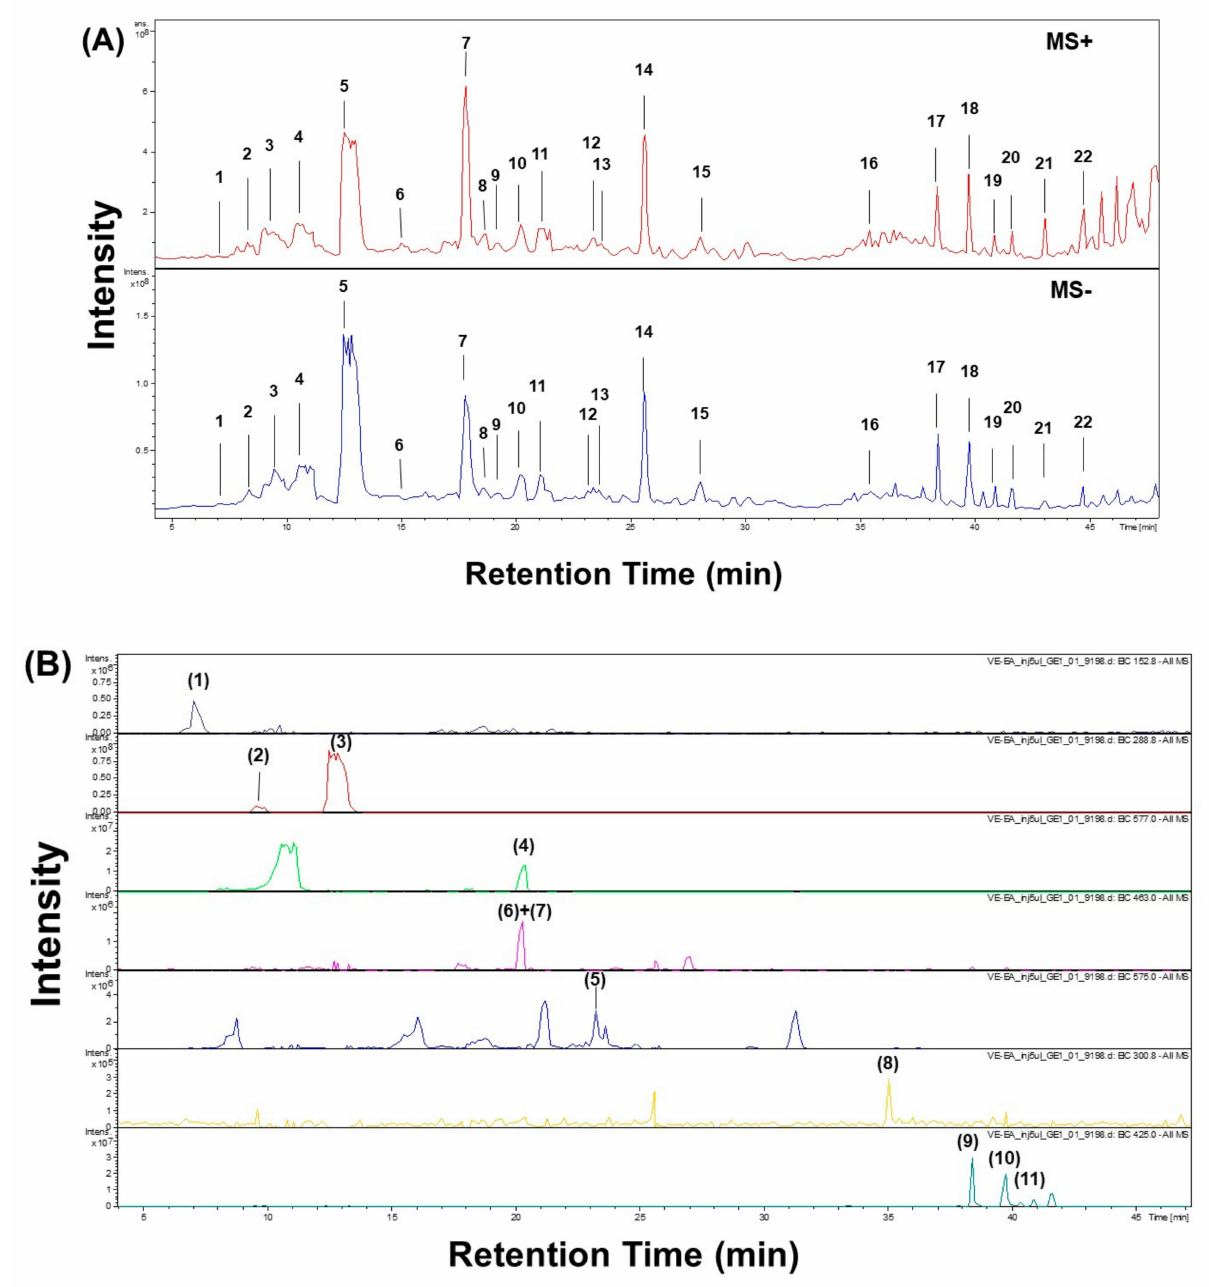
Figure 3. ( A ). LS-ESI-MS chromatograms of EA fraction of V. emarginatum extract in positive (+) and negative ( − ) ionization modes. ( B ). Extraction Ion Chromatograms of Isolated Compounds ( 1–11 ) in negative ( − ) ionization modes. Table 2. Characterization of compounds in EA fraction of V. emarginatum using LCESI-MS/MS in negative ion mode. No. R.T.